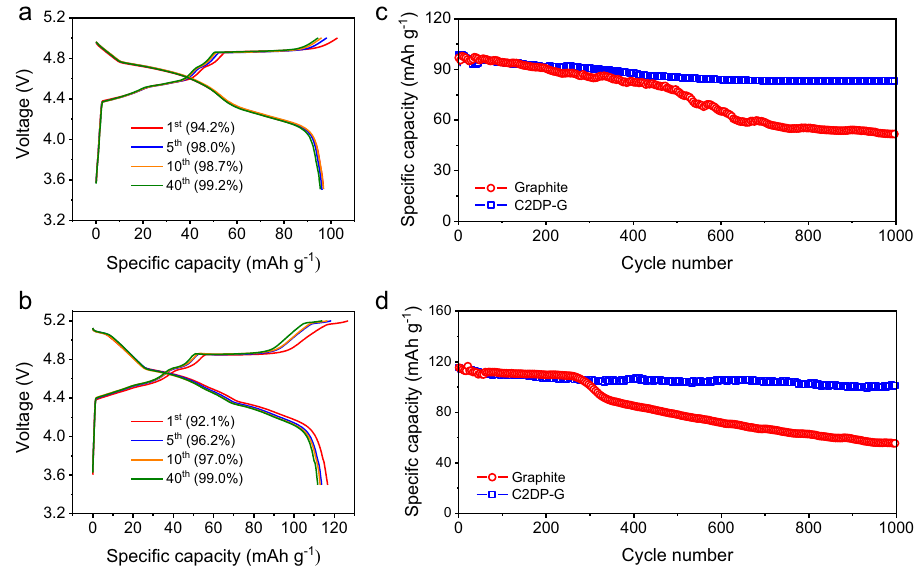
Fig.5|Evaluationofotheranion-intercalationchemistries.a,b The1 st ,5 th ,10 th ,40 th GCDcyclesoftheC2DP-Gelectrodein( a )2MLiFSIand( b )2MLiTFSI. c,d Cycling performance at 1C of the graphite electrode and the C2DP-G electrode in ( c ) 2M LiFSI and ( d ) 2M LiTFSI.